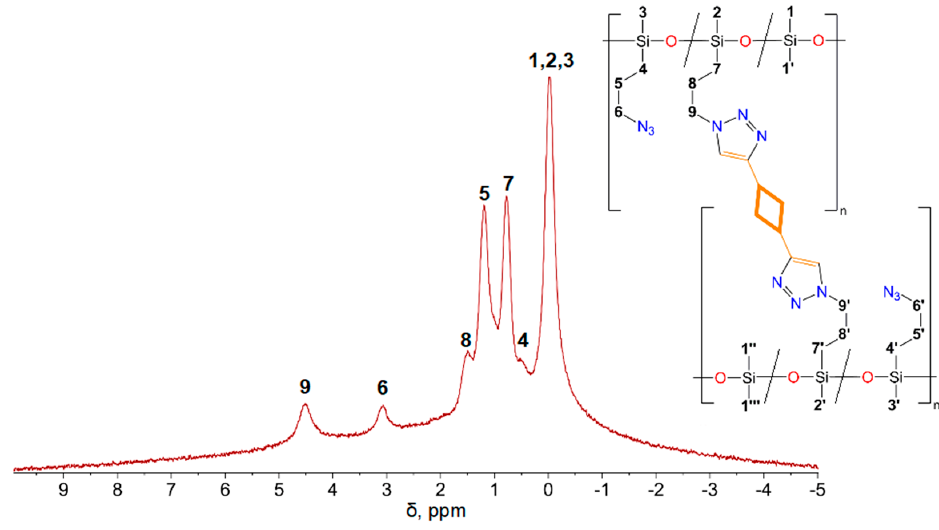
Figure 4. Re2-PDMS solid-state 1 H NMR spectrum.